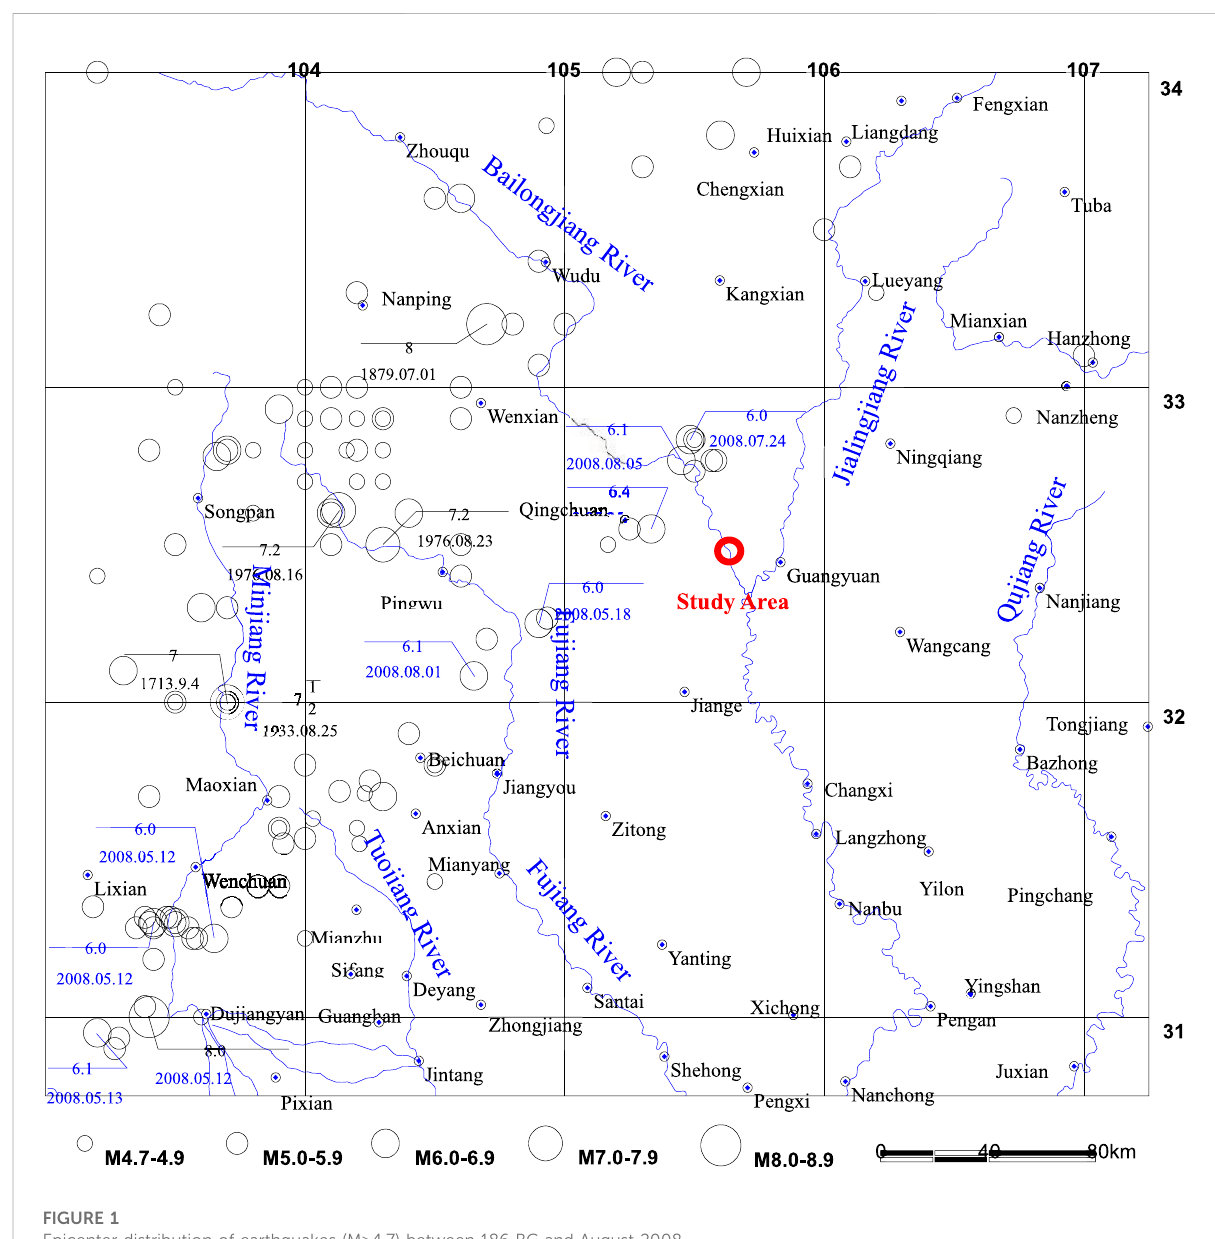
FIGURE 1 Epicenter distribution of earthquakes (M ≥ 4.7) between 186 BC and August